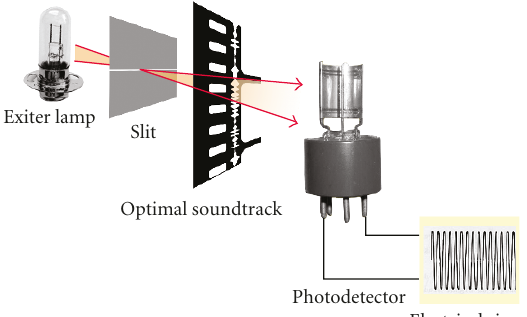
Figure 3: The reproduction process of a VA optical